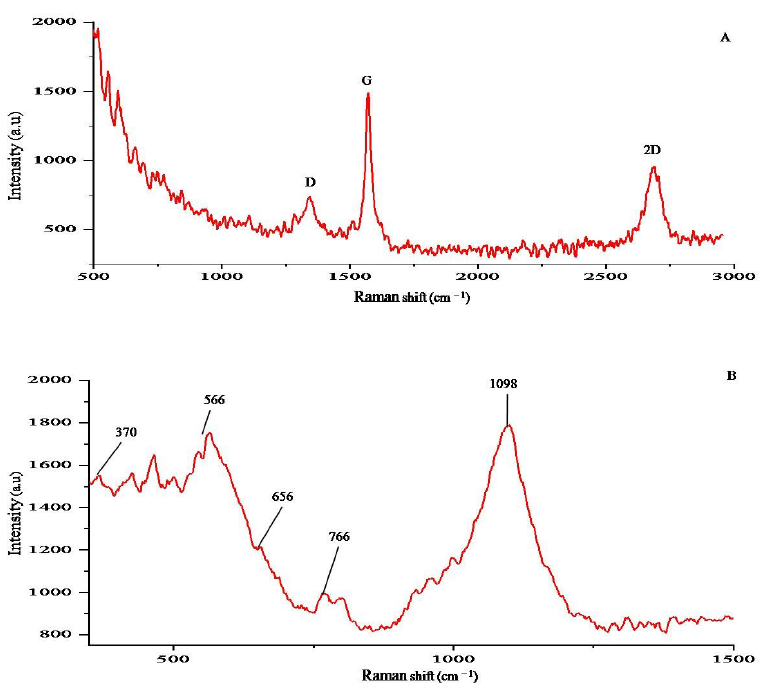
Figure 2. Raman spectrum of ( A ) the bare AuN/CNF electrode and ( B ) 5 (cid:48) amino-linked ssDNA probe-modified AuN/CNF electrode (AuN/CNF/ssDNA (probe)